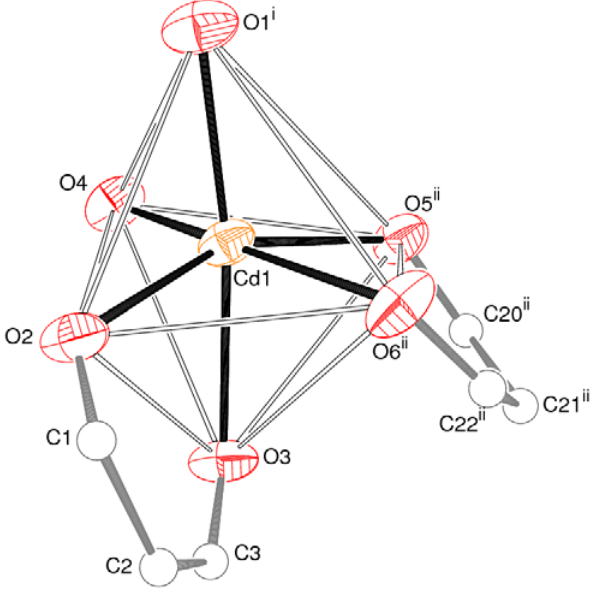
Figure 3. Detail of 1 showing the coordination geometry of the Cd 2+ ion (50% displacement ellipsoids for Cd and O). The octahedral edges are shown as open lines and the C atoms of the chelate rings are shown as spheres. See Table 1 for symmetry